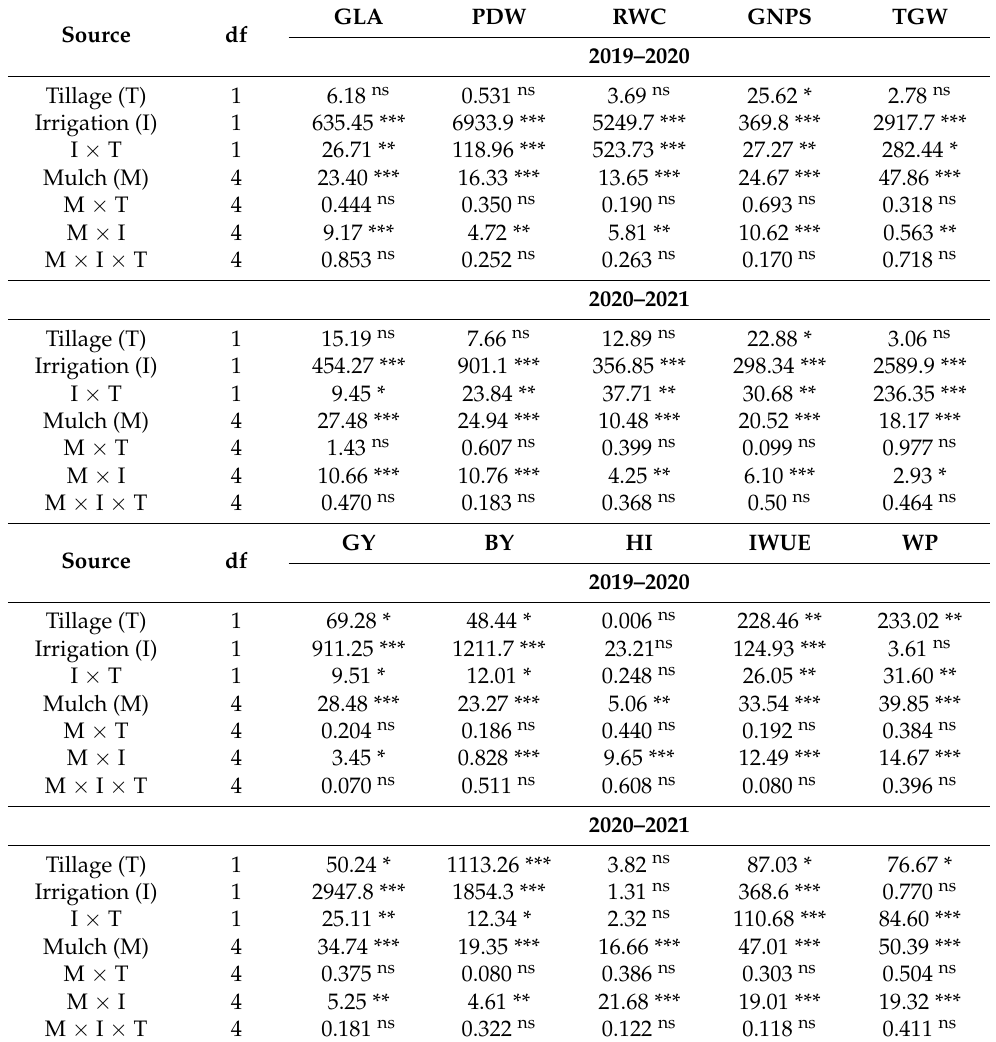
Table 2. Analysis of variance (F-values) on the effects of tillage, irrigation, mulching, and their interaction on different plant traits of wheat for two growing